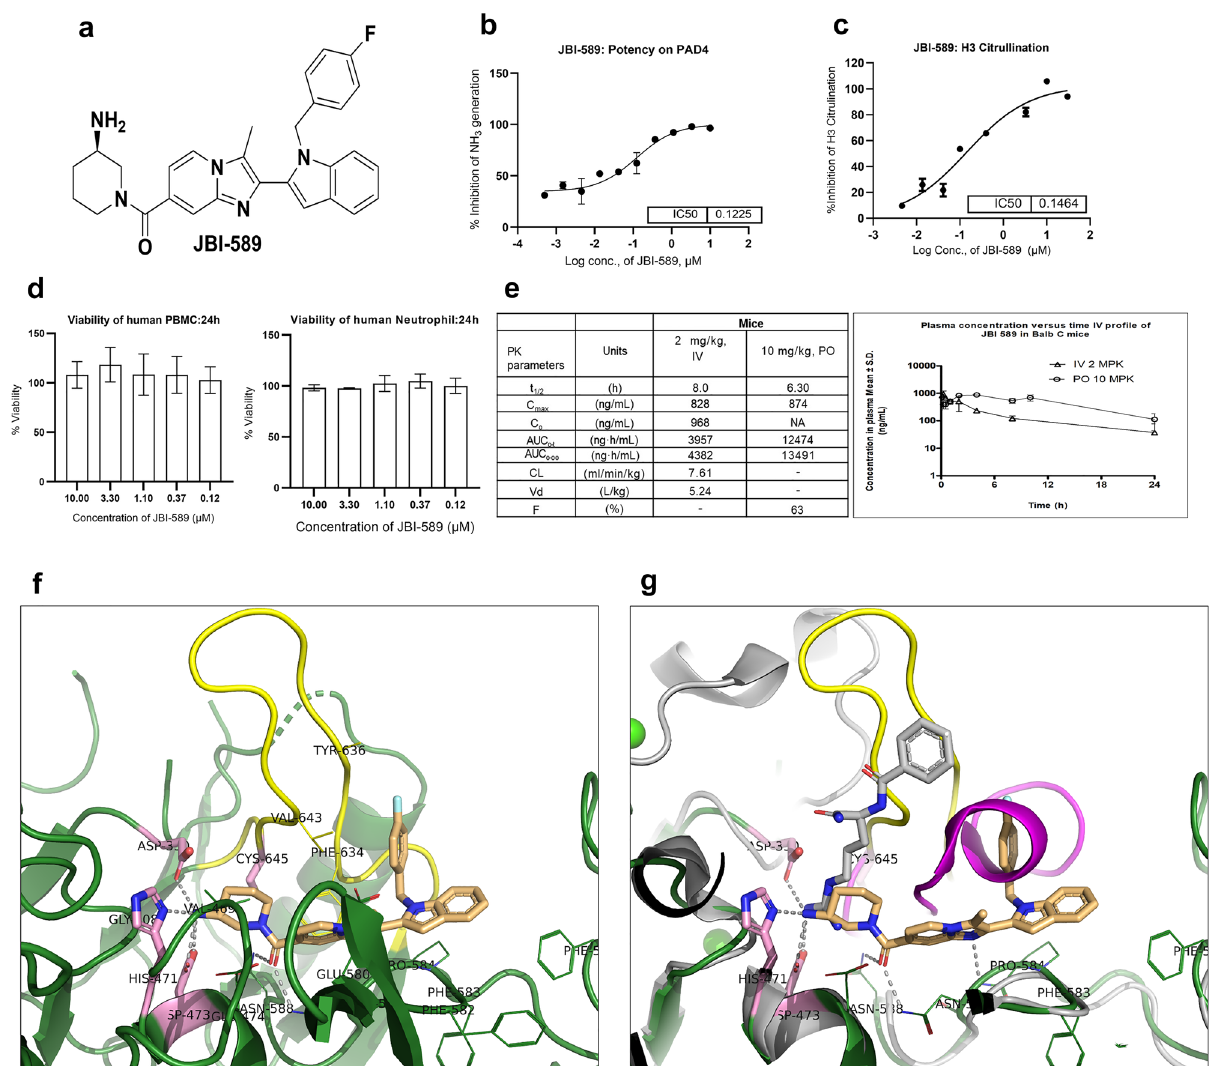
Figure 1. Structure, Biochemical and cellular potency of JBI-589. ( a ). Chemical structure of JBI-589 ( b ) Potency of JBI-589 in PAD4 biochemical assay measuring ammonia release ( c ) Potency of JBI-589 in inhibiting calcium ionophore induced citrullination using purified human neutrophils. ( d ) Effect of JBI-589 on human neutrophil and PBMC viability. ( e ) Oral (10 mg/kg) and intravenous (2 mg/kg) pharmacokinetic parameters of JBI-589 in Balb C mice. ( f ) JBI-589 bound to PAD4 at the active site. JBI-589 is shown in sticks (in light orange color). Catalytic residues (Asp-350, His-471, Asp-473, Cys-645) are shown in pink. Residues within 4 Å of JBI-589 are shown in lines. Inhibitor-protein interactions are shown in grey dotted lines. ( g ) Overlay of JBI-589 bound PAD4 (green, calcium-free) onto BAA bound PAD4 (grey, PDB: 1WDA). JBI-589 (light orange sticks) and substrate-like inhibitor, BAA (grey sticks) are oriented ~ 70° to each other. Region aa630-aa647 shows conformational change and movement from helix (in BAA-PAD4, magenta) to ß-hairpin/loop (in JBI- 589-PAD4, yellow). Calcium ions seen in BAA-PAD4 are shown in green spheres. For clarity, few residues are duction of anti-H3Cit antibody: (Granulocyte-colony stimulating factor (G-CSF)-modified Collagen-Induced Arthritis (CIA) model in C57/Bl6J mice and standard CIA model in DBA/1 mice) 15,41 . Oral administration of JBI-589 twice daily from day 20 to day 56 showed a significant effect on arthritis incidence and severity (Fig. 3a) in the G-CSF modified CIA model. JBI-589-treated mice had reduced serum Interleukin -6 (IL-6) but comparative anti-Collagen Type II (CII) IgG and IgG2c antibody levels (Fig. 3b). JBI- 589-treated mice showed lower plasma levels of H3Cit compared with vehicle-treated mice on day 22 (Fig. 3c). When evaluated by micro-computed tomography (micro-CT), we observed fewer areas of eroded surface of bones in JBI-589-treated mice (Fig. 3d) as compared to control mice. H&E staining of ankle joint to examine inflammation (exudate and infiltrate) revealed JBI-589-treated mice had alleviated severity of arthritis compared with vehicle-treated mice (Fig. 3e). Immunofluorescence microscopy revealed lesions positive for H3Cit and Ly6G and DNA within the joint space and on the bone surface in vehicle-treated mice but not in JBI-589-treated